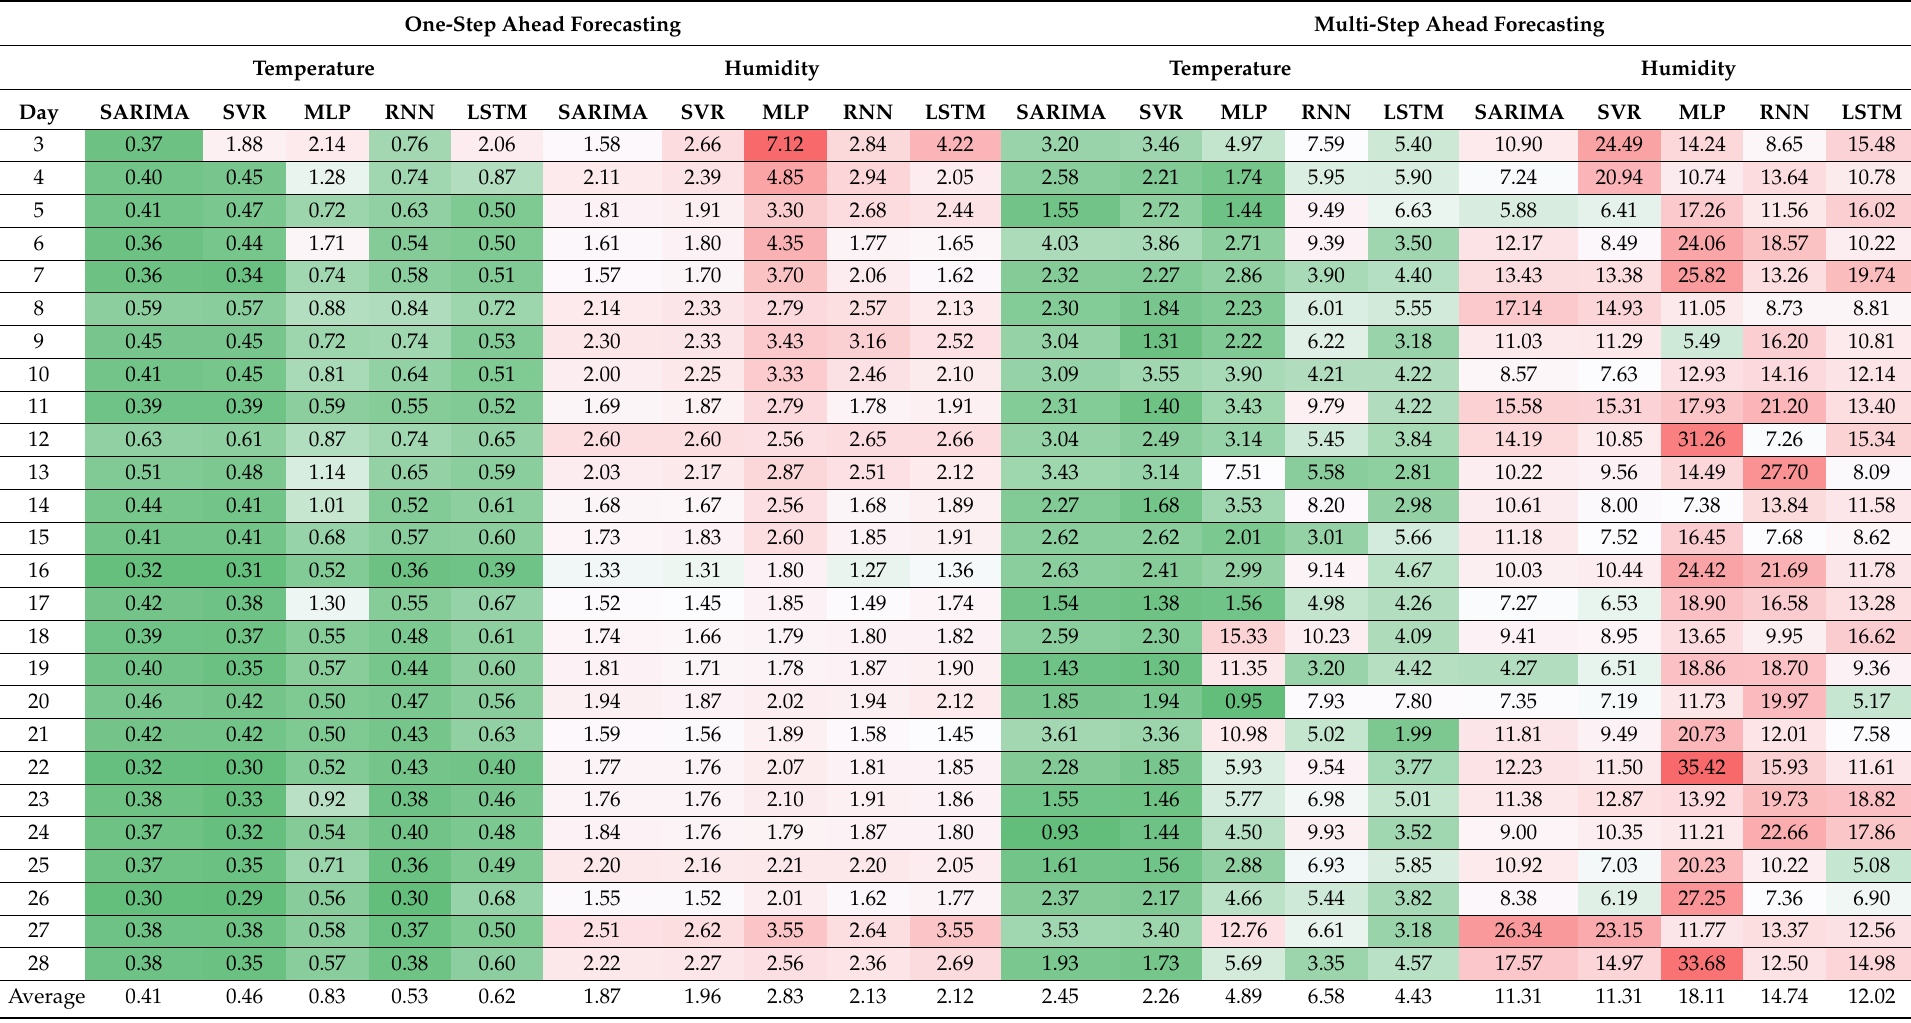
Table 3. Root Mean Square Error (RMSE) for One-step vs. Multi-step ahead forecasts using Time-Series Forecasting Algorithms (TSFAs) with a forecast horizon of 1-day (96 observations) ( colors represent the scale of values—assigned individually for one-step and multi-step ahead forecasts